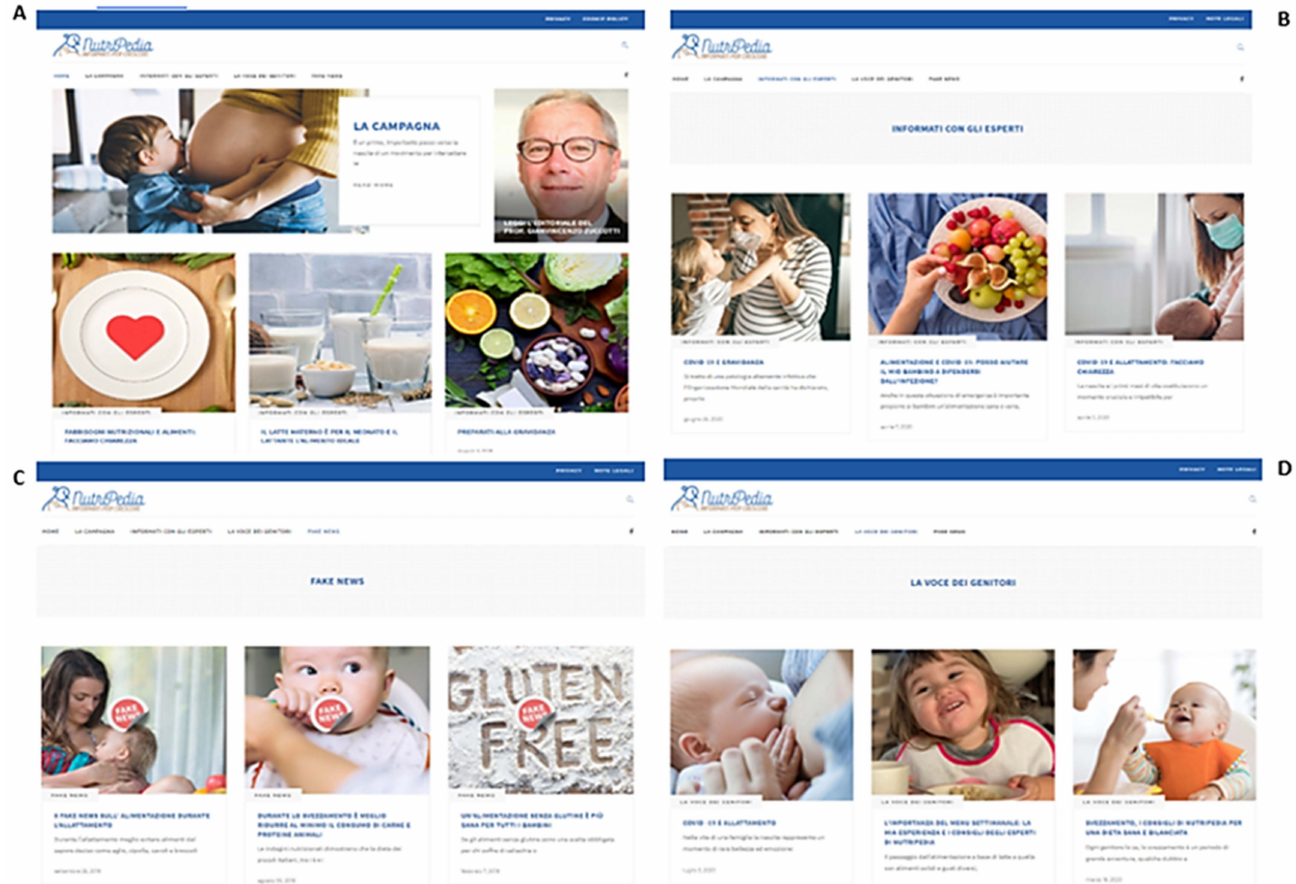
Figure 3. Impression on user interface ( A ), “The Expert voices ” landing page ( B ), “Fake news” landing page ( C ), “The parents’ voices ” landing page ( D ).